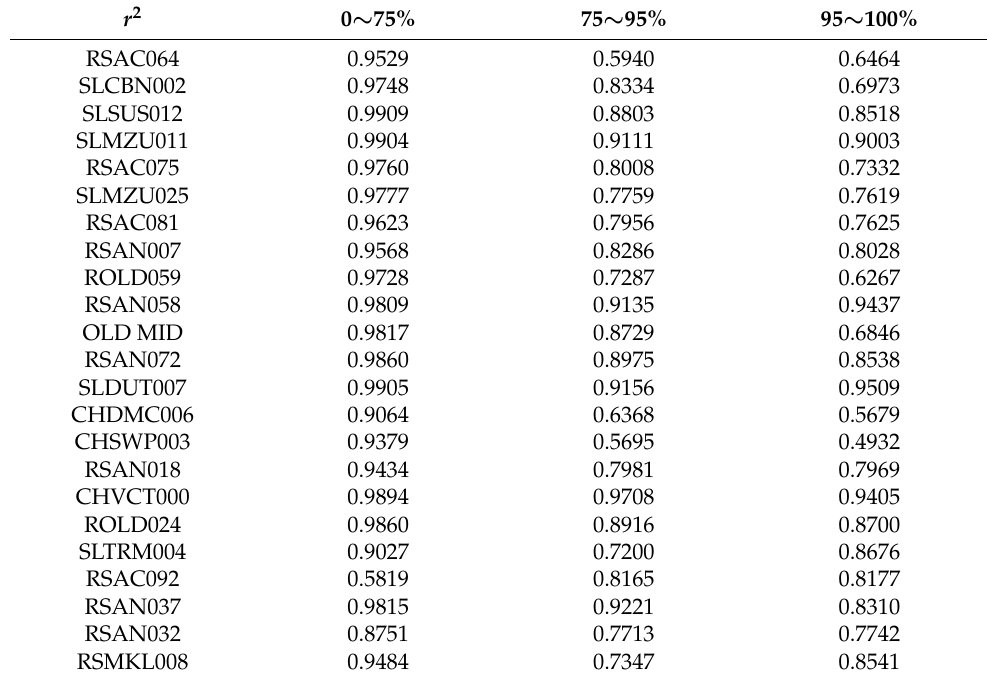
Table A2. Station-wise r 2 results of Res-LSTM at hourly time step with daily